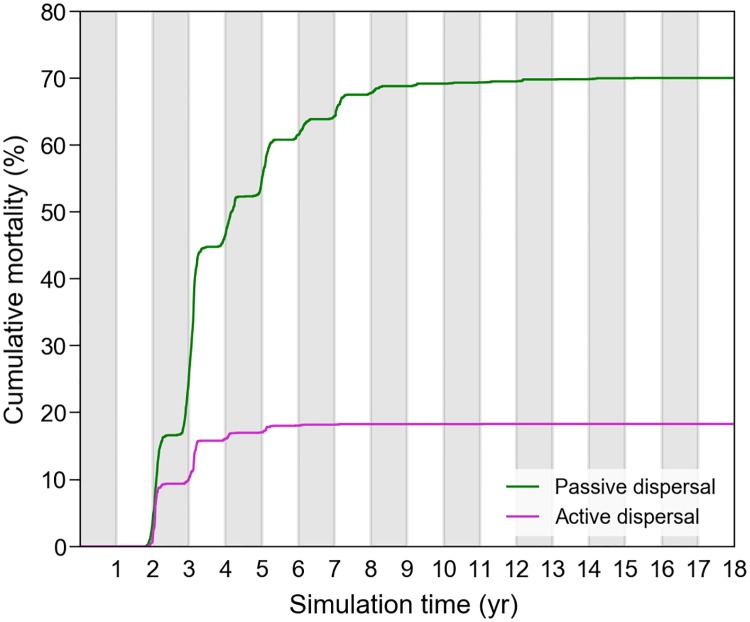
Cumulative cold-induced mortality in passive and active turtles.